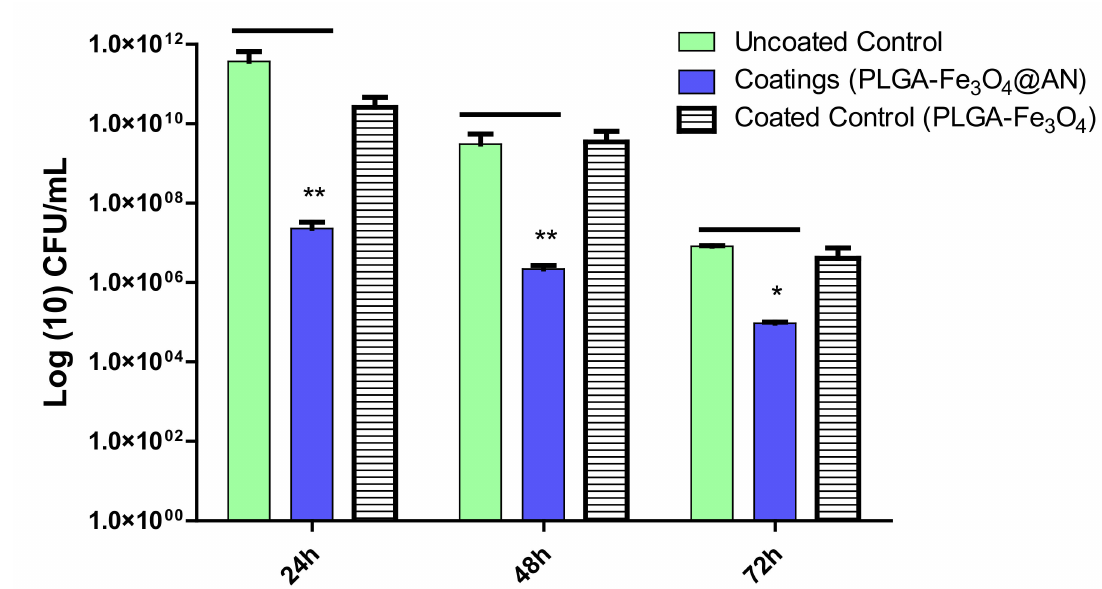
Figure 7. S. aureus biofilm formation (expressed as CFU (colony-forming units) / mL values) on control and coated surfaces for 24, 48, and 72 h of incubation at 37 ◦ C (* p ≤ 0.05, ** p ≤ 0.01; comparison of coating versus control sample for the same time interval).